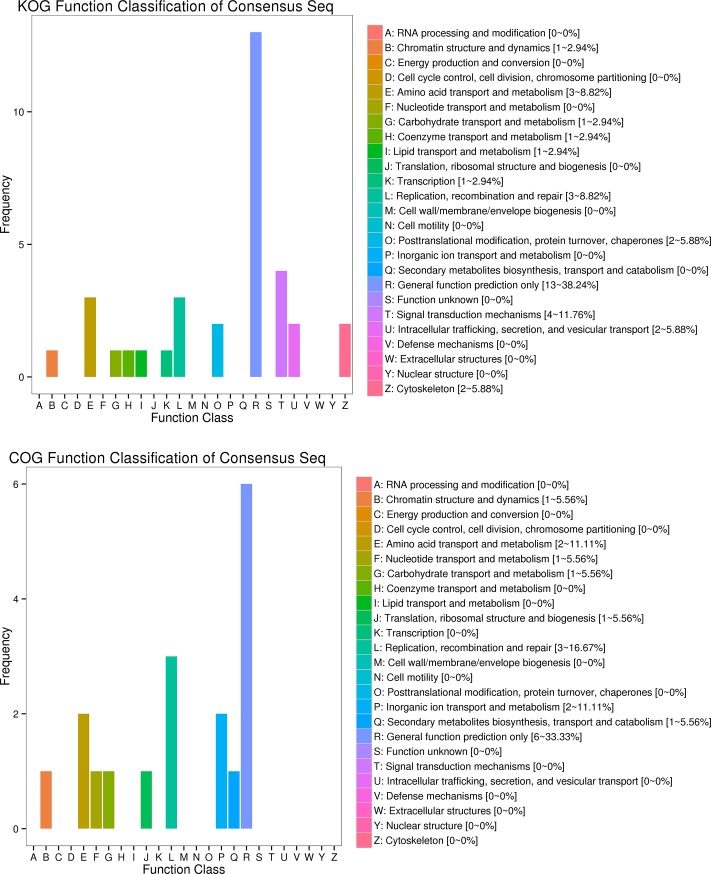
KOG and COG functional classification of differentially expressed genes between the selection and control groups.